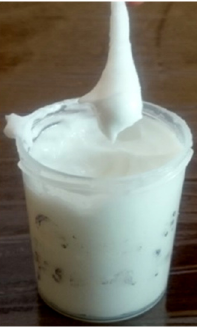
Figure 1. Lavandula stoechas essential oil topical cream formulation.